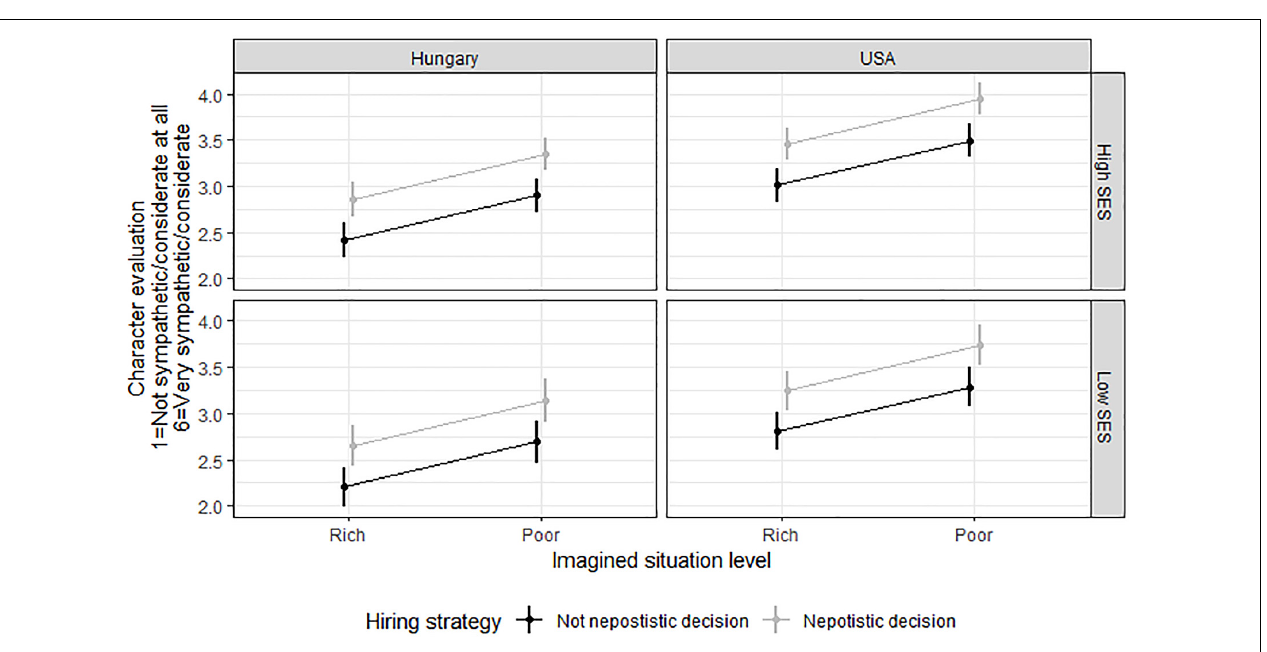
narcissistic tendencies or entitlement (Piff et al., 2010;